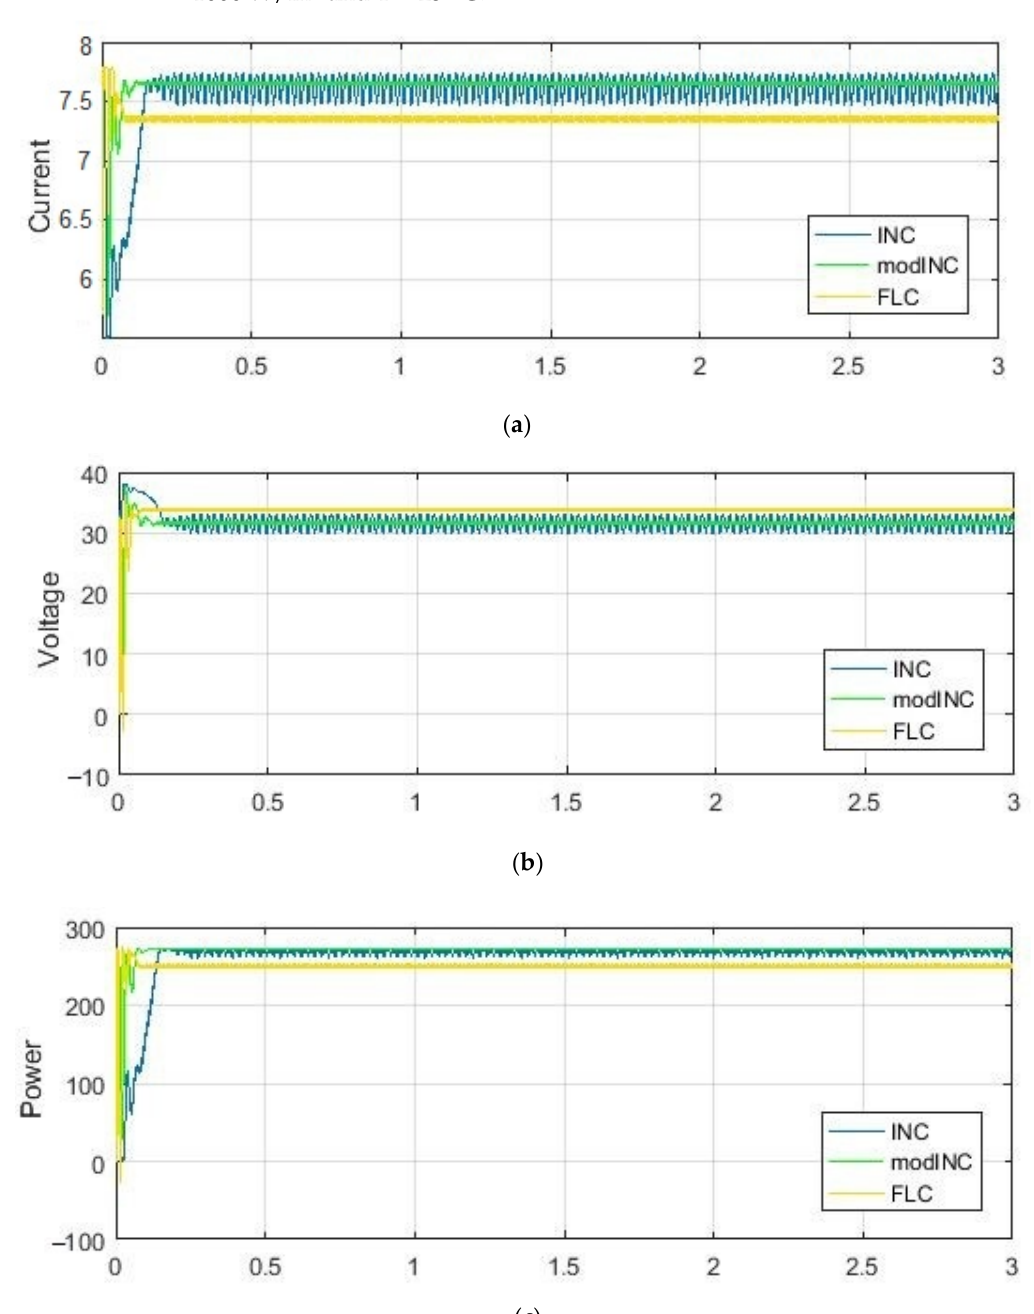
Figure 11. ( a ) Output current using INC, modINC, and FLC, by changing the temperature. ( b ) Output voltage using INC, modINC, and FLC, by changing the temperature. ( c ) Output power using INC, modINC, and FLC, by changing the temperature.